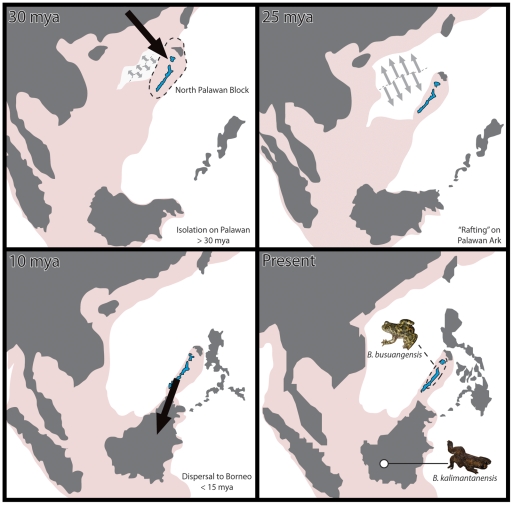
Proposed “Palawan Ark Hypothesis” based on reconstructions of geological history of Southeast Asia [16].Pale red represents submarine continental margins. Large black arrows indicate proposed dispersal routes; small gray arrows indicate sea-floor spreading.